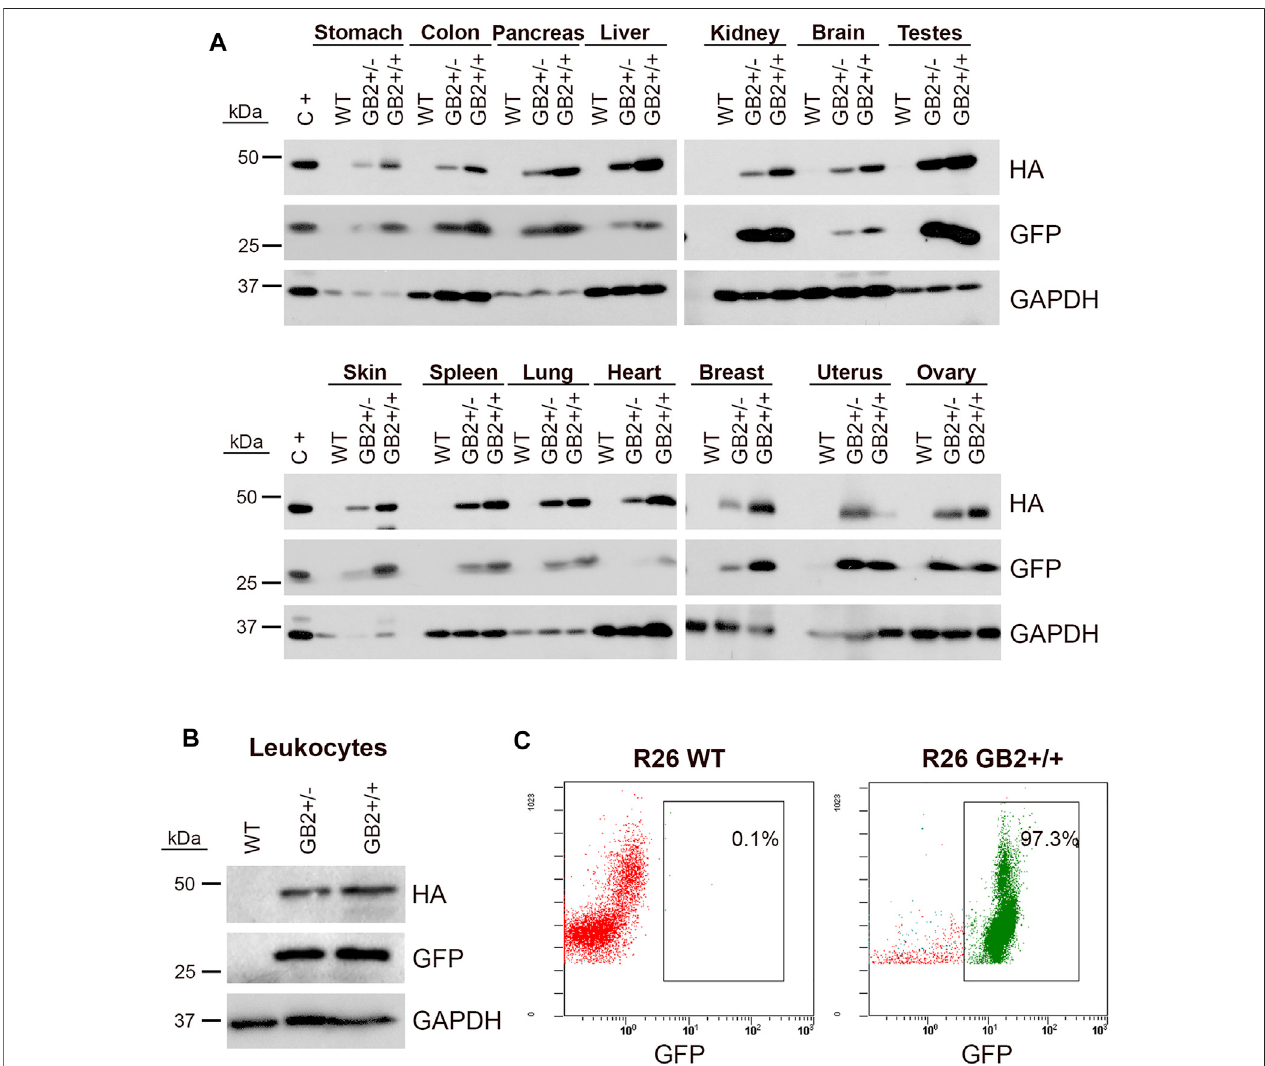
FIGURE2| Ubiquitousexpression ofGSDMB2-HAand GFP intheR26-GB2mousemodel. (A) Representativewesternblotanalysisindifferent tissues from GB2 (+/- heterozygous; +/+ homozygous) and WT (control) littermate mice. GAPDH was used as a loading control. C+, MCF7 exogenously expressing GSDMB2-HA and GFPgeneswereusedasapositivecontrol. (B – C) ExpressionofGSDMB2-HAandGFPtransgenesbyWB (B) andGFPby fl owcytometry (C) inwholebloodleukocytes from R26-GB2 mice. Full-length blots are presented in Supplementary Figure S1 .